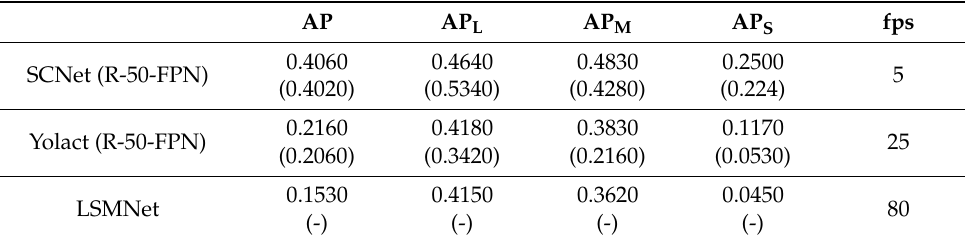
Table 5. OCIS results (AP@IoU = 0.50:0.95) on the COCO-car (COCO) dataset.